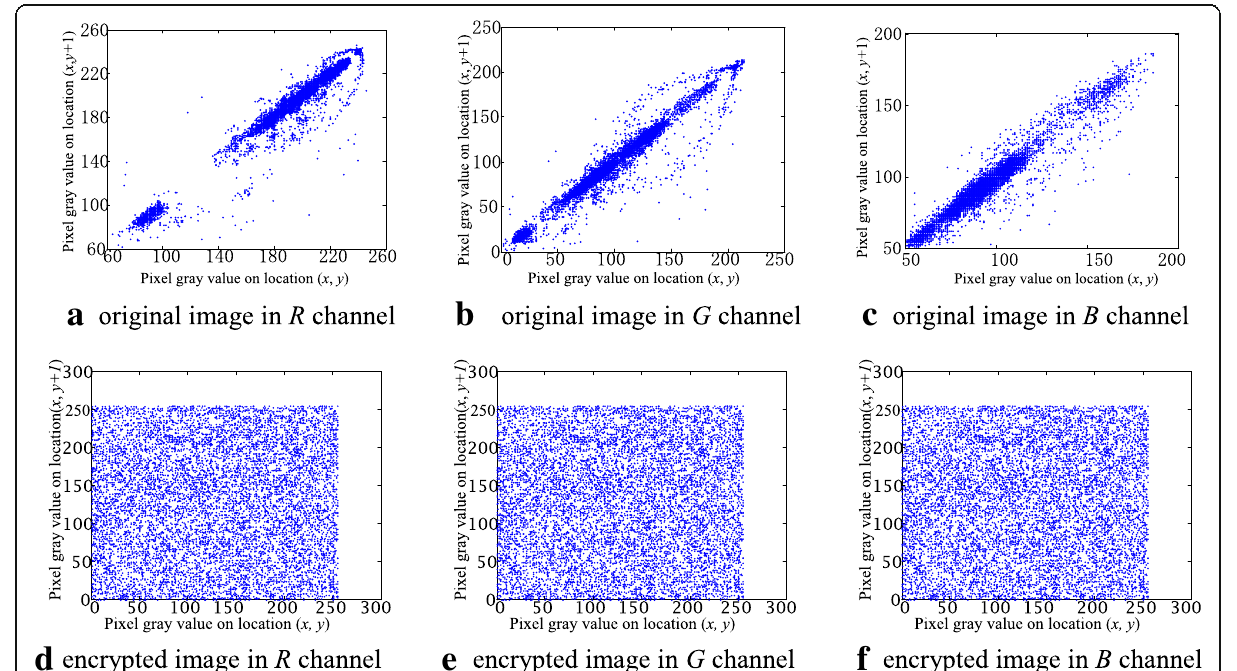
Fig. 6 Correlation distributions between two horizontal different pixels. a Original image in R channel; b original image in G channel; c original image in B channel; d encrypted image in R channel; e encrypted image in G channel; f encrypted image in B